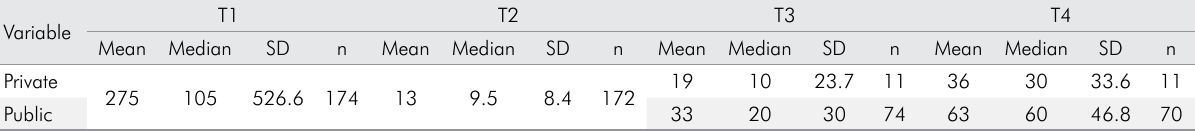
Table 2. Data of the time gap (in days) between the first symptom of the lesions, diagnosis and treatment of patients. T1 T2 Variable